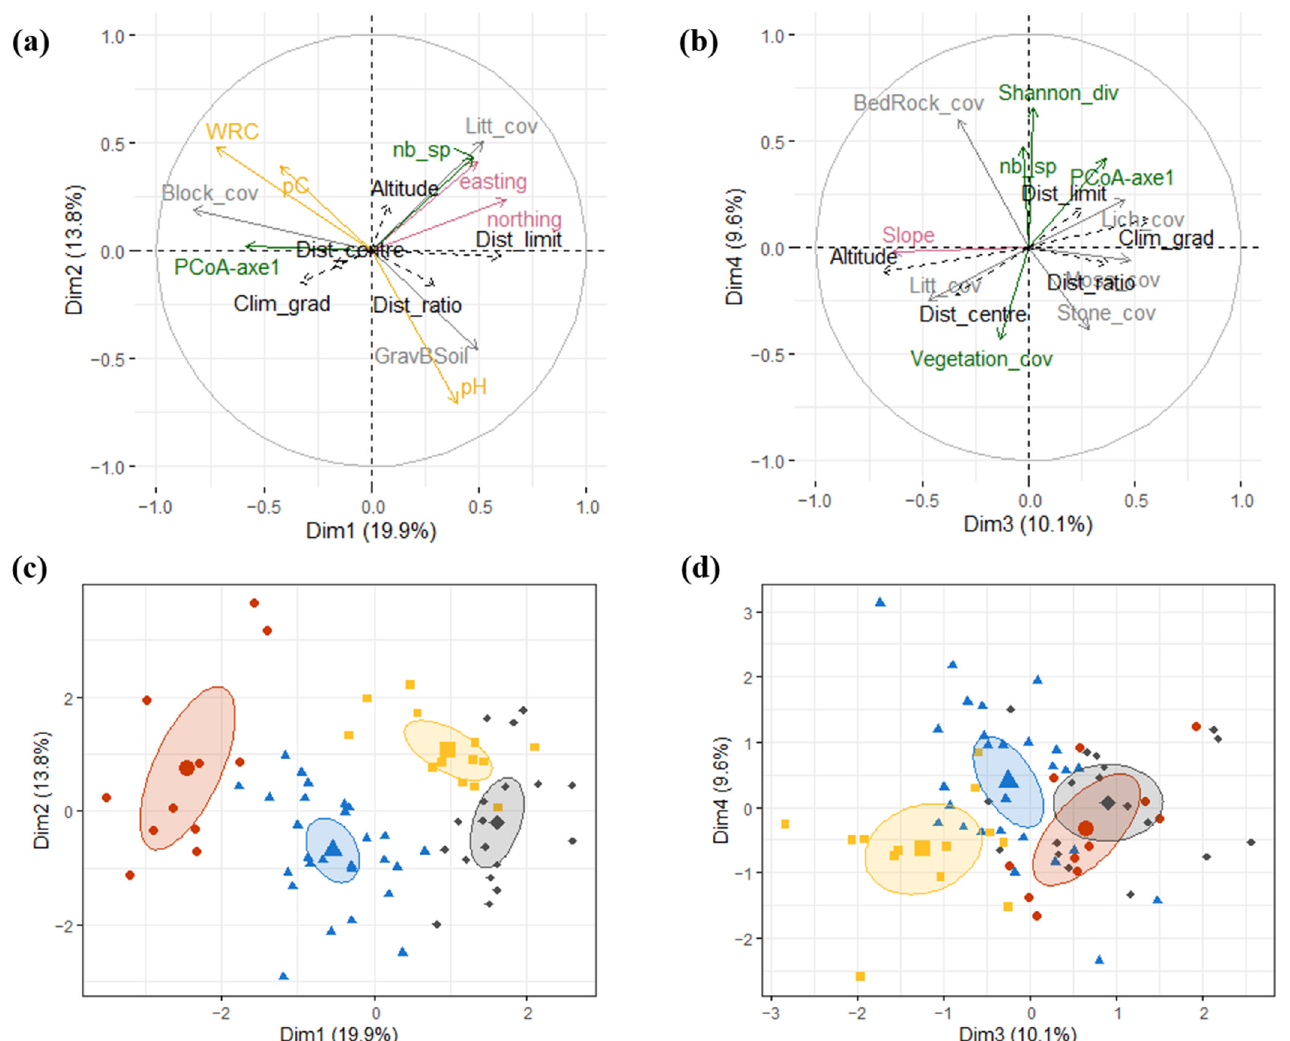
Figure 4. Illustrations of the four main micro-niche types revealed by MFA and HCPC analyses. ( a , b ) Positions of parameter variables following MFA for the four main environmental axes. Each colour represents a group of micro-niche characteristics: soil cover (grey), biotic niche (green), topographic niche (pink), edaphic niche (mustard). Only the 10 variables that best represent the plan are plotted (according to their cos 2 ). “Marginality” variables are supplementary variables in the MFA and plotted in black. ( c , d ) quadrat positions according to the HCPC results. The four HCPC clusters are plotted with different symbols: red circles for micro-niche type 1, blue triangles for type 2, orange squares for type 3, grey diamonds for type 4. Ellipses correspond to confidence interval at the 0.99 level. The first two axes of the MFA are on the left ( a , c ), while axes 3 and 4 are on the right ( b , d